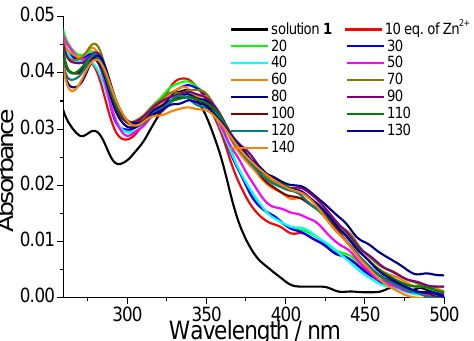
Figure 10. ( a ) The fluorescence titration of solution 1 by Zn 2+ . ( b ) The curves of the fluorescence emission intensity ratio of I 545 /I 408 of solution 1 versus the concentration of Zn 2+ . The inset figures were images of solution 1 before and after adding Zn 2+ under 365 nm light lamp.